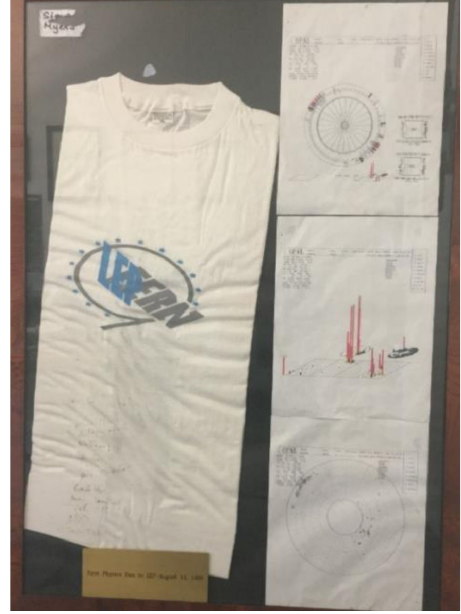
FIG. 24. LEP T shirt signed on the occasion of the first